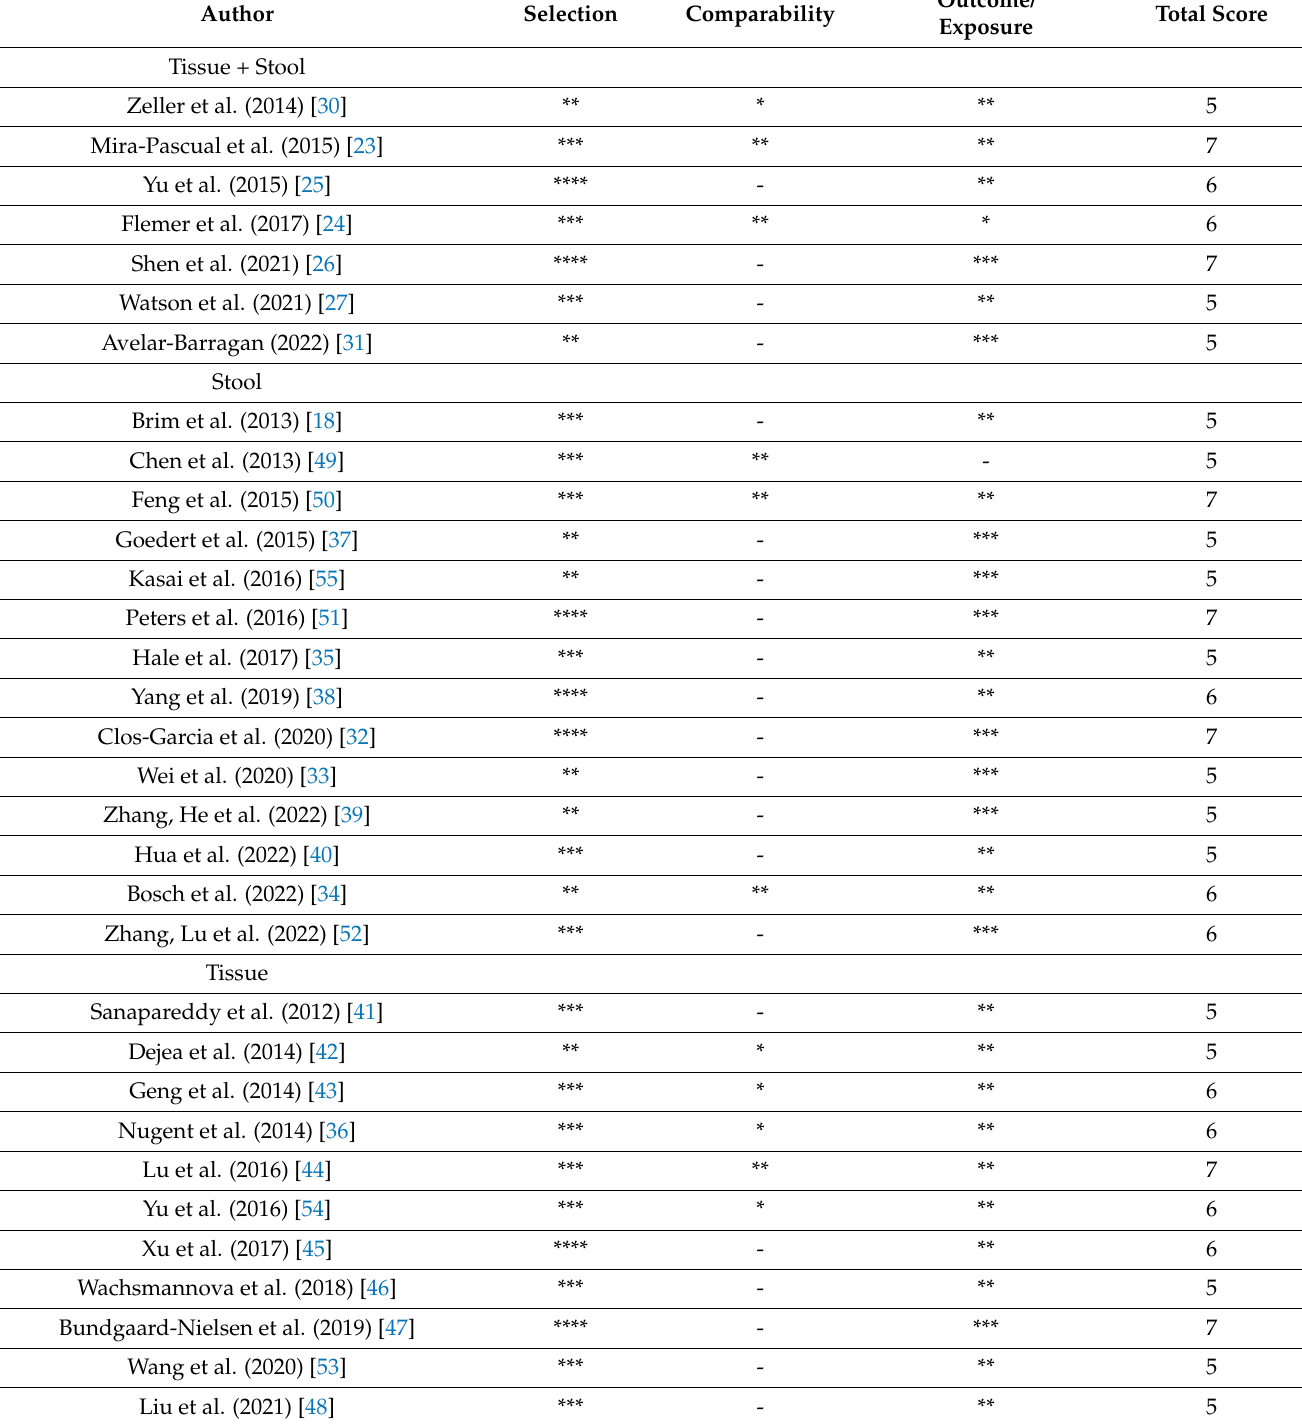
Table 2. Quality assessment of the selected studies according to the star score of the Newcastle– Ottawa scale (NOS), based on which * are assigned to three criteria, i.e., selection (with a maximum of 4 stars [****]), comparability between case and controls (with a maximum of 2 stars [**]), and ascertainment of effects of microbiota—outcome/exposure (with a maximum of 3 stars [***]) for a potential score ranging from 0 to 9 points. Higher scores indicate a lower risk of